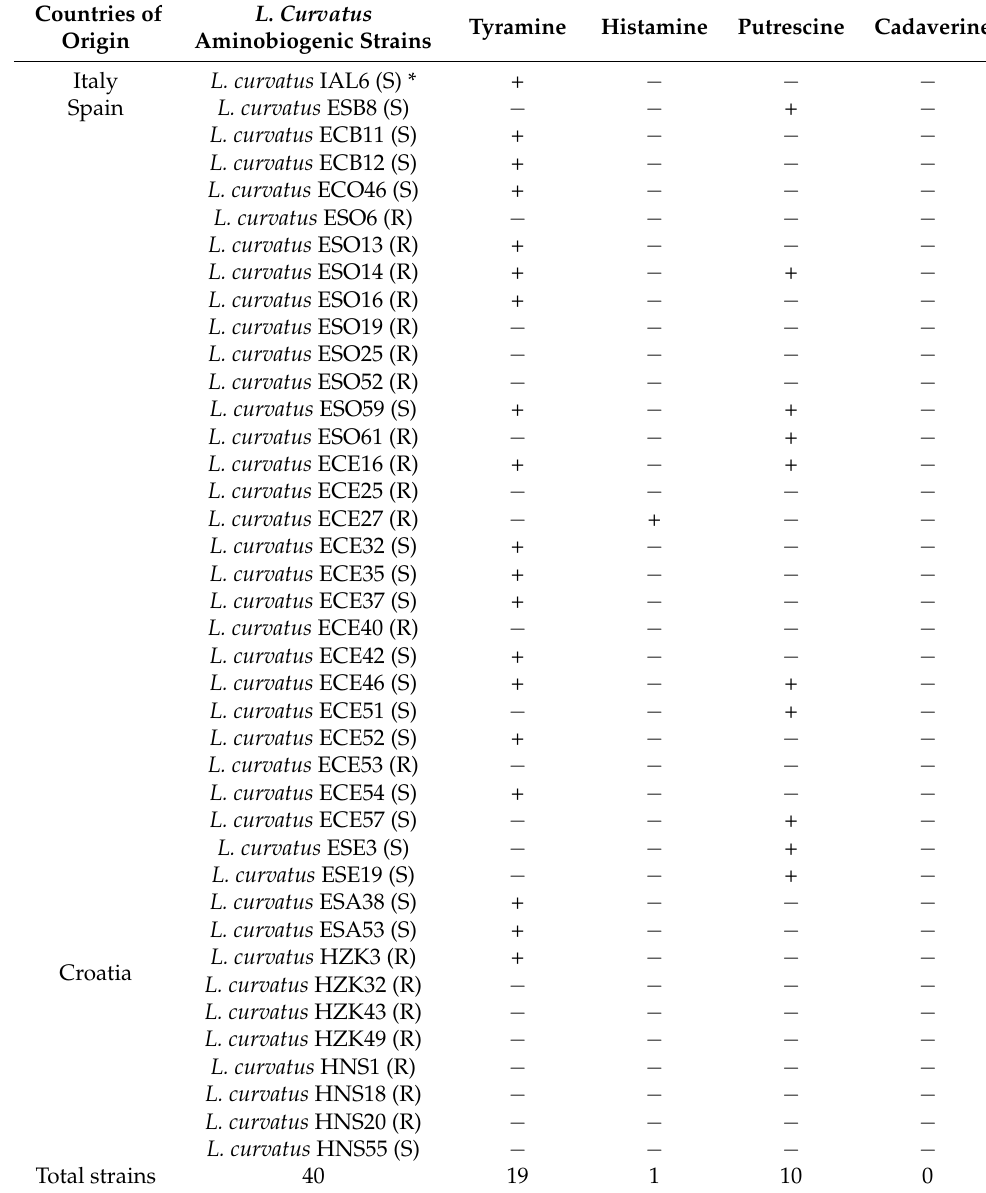
Table 4. BAs production by L. curvatus strains sorted by origin. *: the presence of (S) or (R) indicates an antibiotic-sensitive or antibiotic-resistant strain,